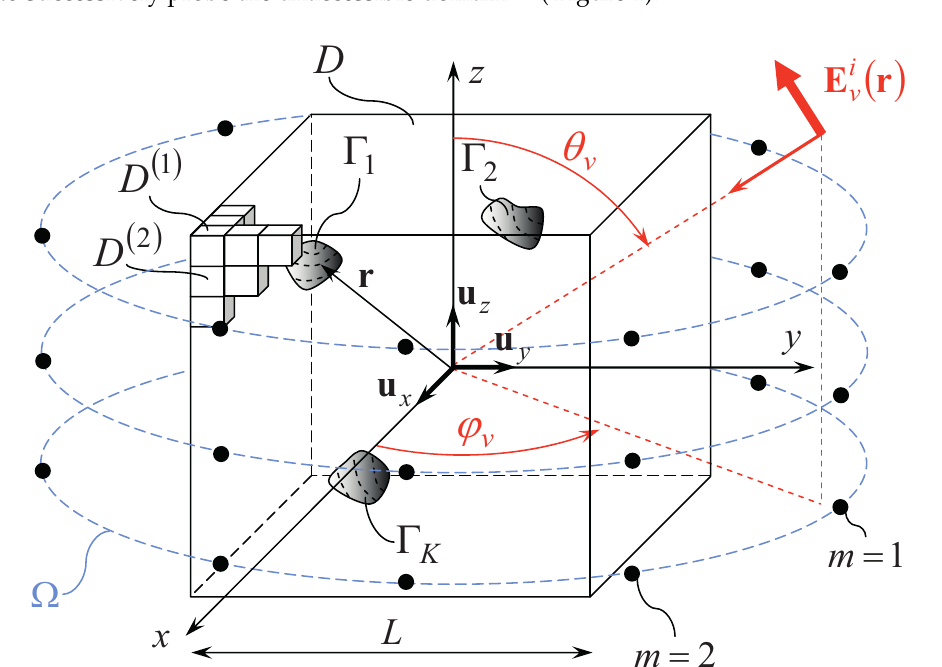
Figure 1. Geometry of the 3 D-MI microwave imaging